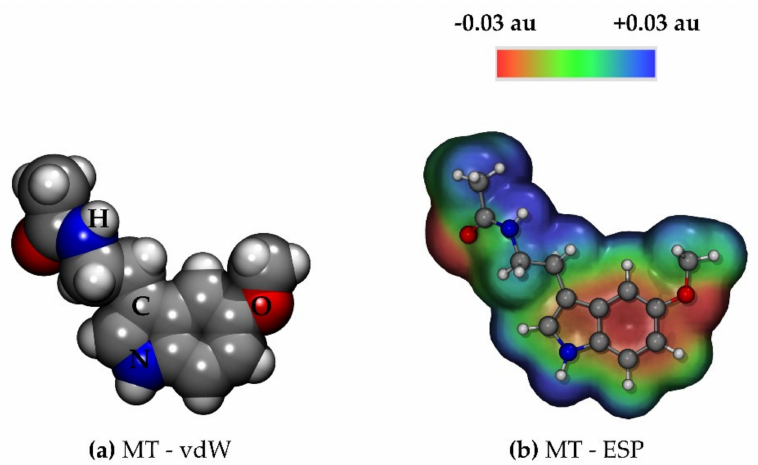
Figure 1. ( a ) PBEh-3c optimized structure of the extended conformer of melatonin in vdW represen- tation. ( b ) Ball and stick representation overlapped to the ElectroStatic Potential (ESP) map plotted on the electron density (ISO electron density value = 10 − 3 au). Atom colors: H white, C grey, N blue, O